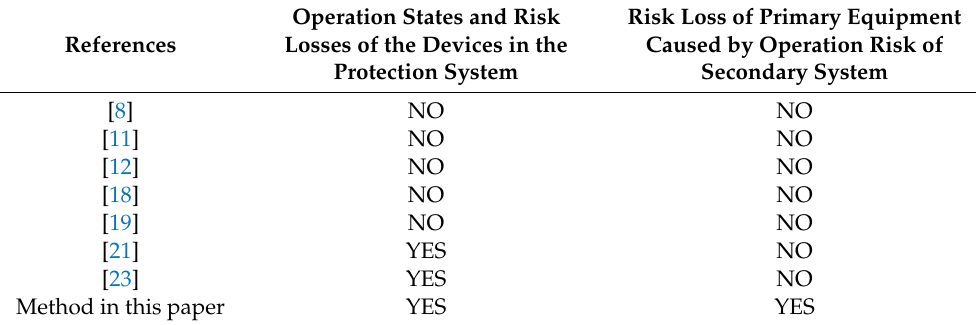
Table 9. Comparison analysis with some existing